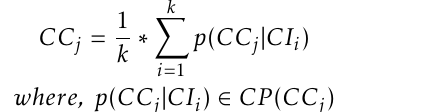
combinations of CC . However, based on the